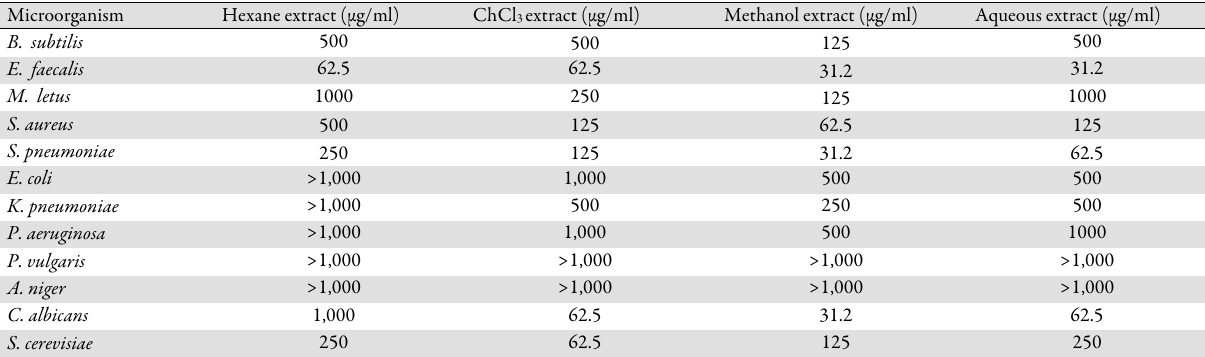
Table 2. MIC values of Bridelia retusa fruit extracts against tested microorganisms Microorganism Hexane extract (µg/ml) ChCl 3 extract (µg/ml) Methanol extract (µg/ml) Aqueous extract (µg/ml)